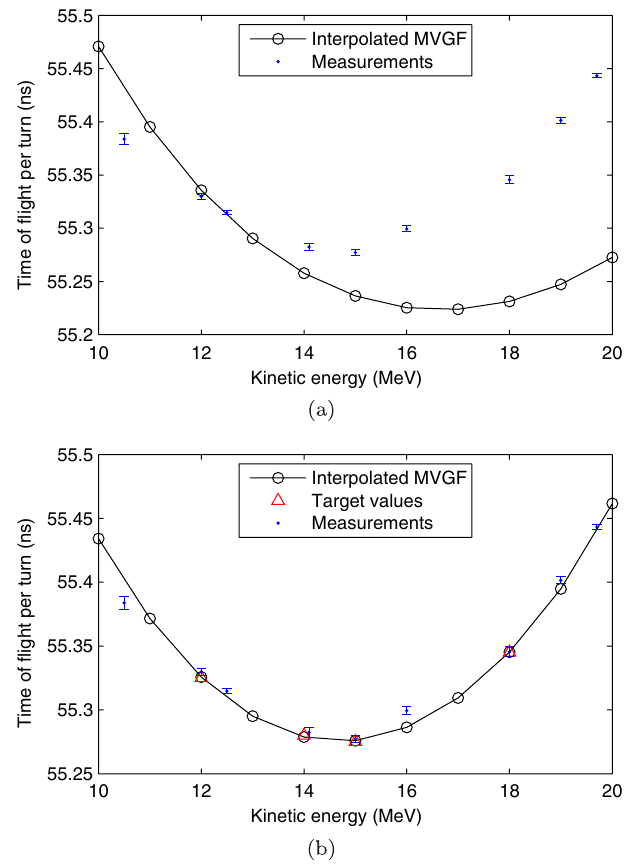
FIG. 16. (a) Comparison between measurements and simula- tions of the time-of-flight variation with energy for the baseline lattice configuration. We observe that the measured lattice has a minimum time of flight of 55.275 ns at 15 MeV whereas the model lattice (with the same nominal magnet strengths and positions as used in the machine) has a minimum time of flight of 55.225 ns at 17 MeV. (b) From the time-of-flight measure- ments (blue points with error bars) four constraints (red tri- angles) are defined for the optimization routine used to find a model lattice configuration with the same dynamical behavior as observed in the machine. The time of flight for a range of energies between 10 and 20 MeV is then computed for the fitted lattice (black line with circles) found by the optimization routine. The time of flight in the fitted lattice is in good agreement with the time-of-flight